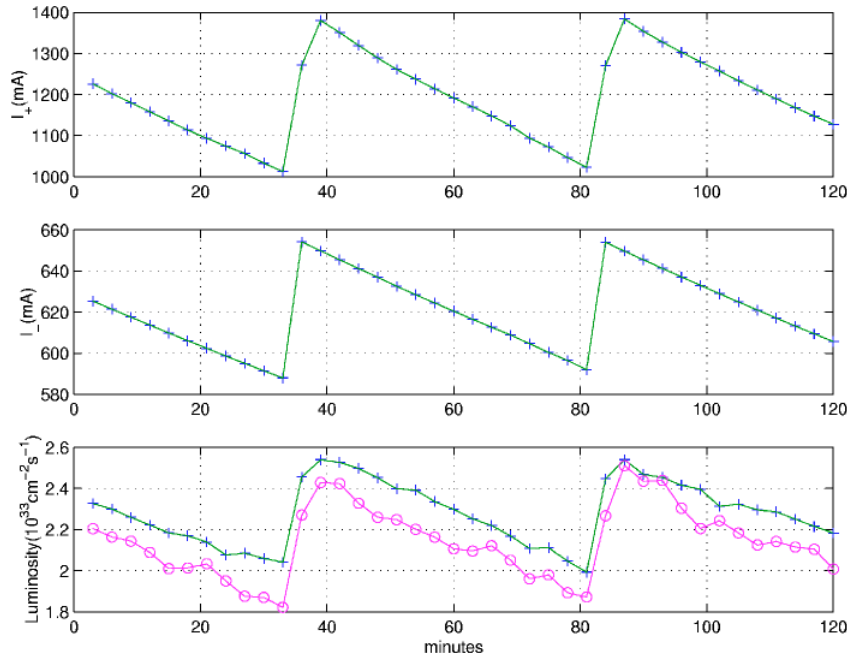
FIG. 6. (Color) Luminosity of a routine operation of PEP-II. The crosses represent measurement and the circles represent simulation. The number of bunches was 605.